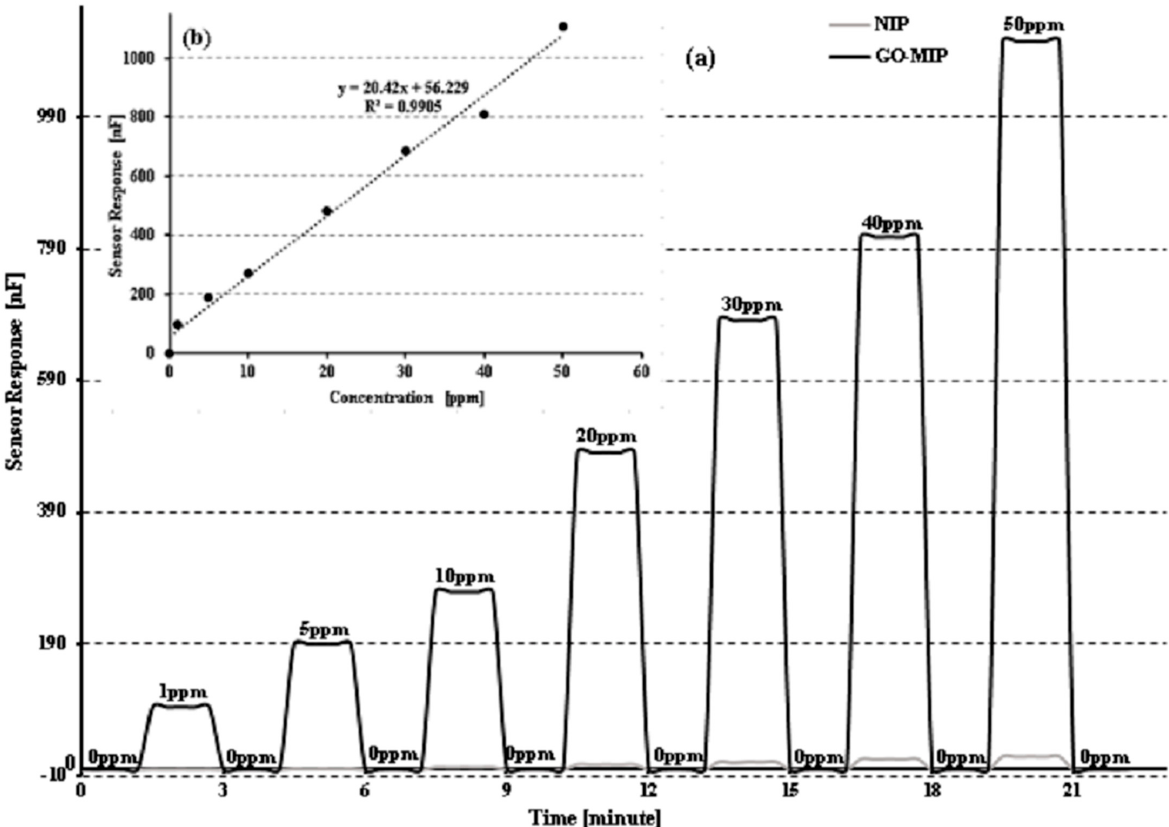
Figure 7. ( a ) Sensitivity response of GO-MIP composite and NIP of polyurethane-based sucrose sensor at different concentrations (0–50 ppm); ( b ) linear regression analysis of sucrose sensor.